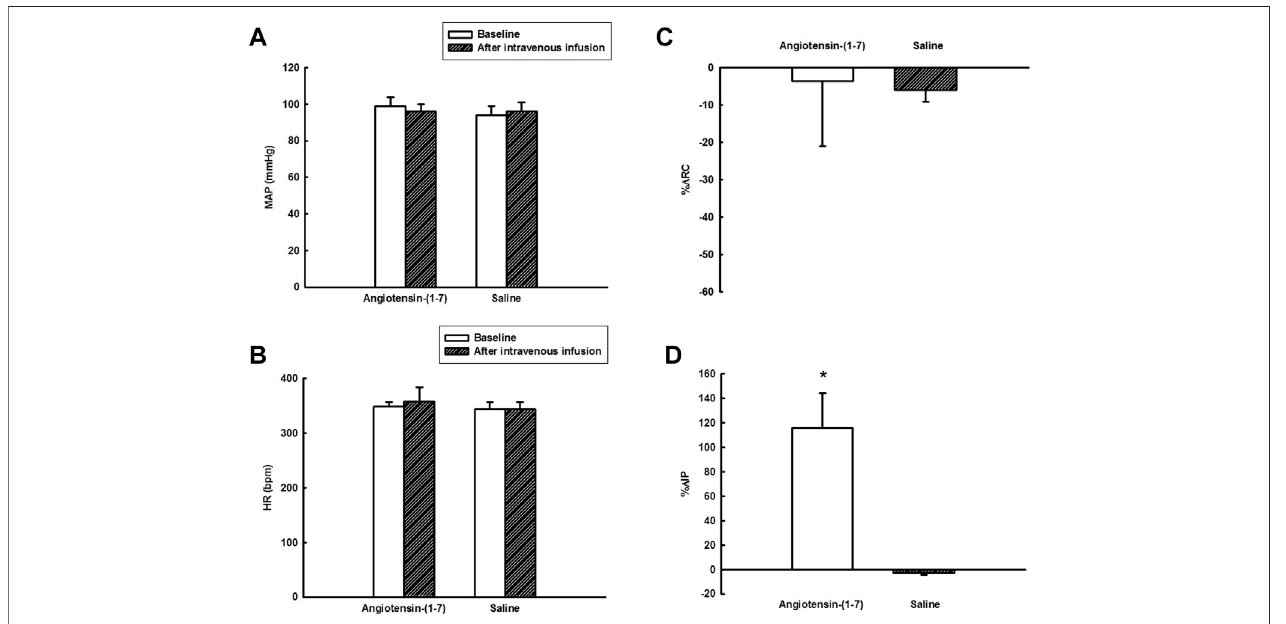
FIGURE3| (A) Mean arterial pressure(mmHg)and (B) heart rate(bpm) at baseline and after intravenous administration ofangiotensin-(1 – 7)(0.24 μ g/kg) or saline, (C) percent change in renal conductance (% Δ RC), and (D) percent change in intravesical pressure (% Δ IP) evoked by intravenous administration of angiotensin-(1 –